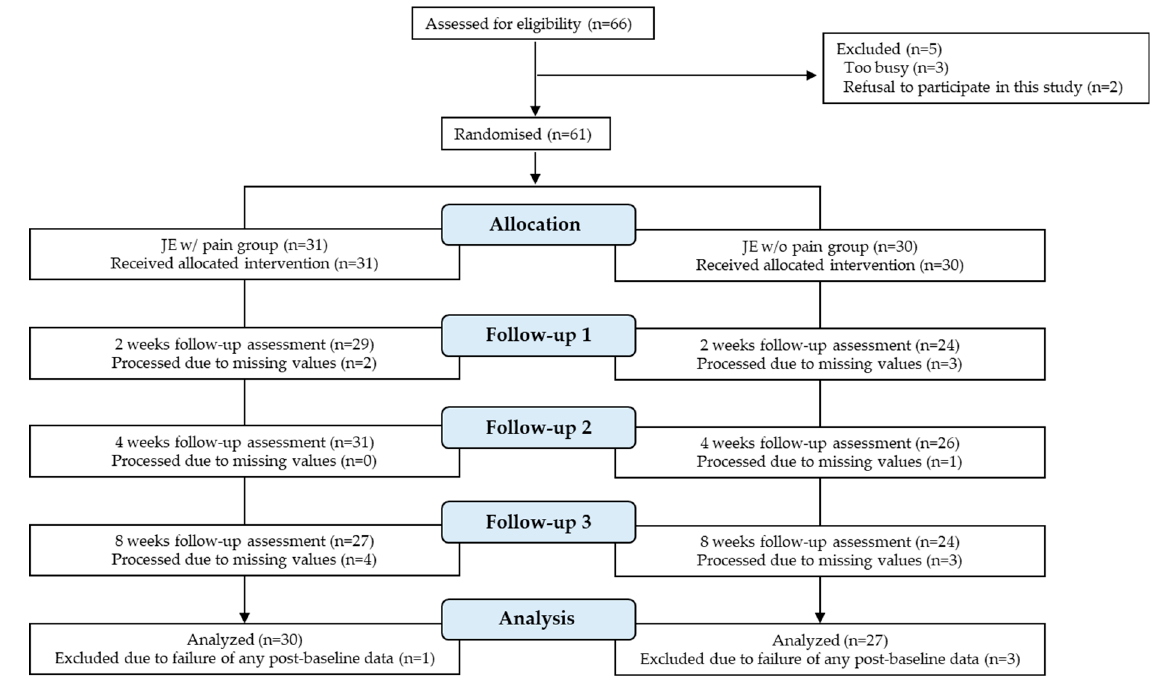
Figure 3. CONSORT flow diagram for our randomized controlled trial. Table 1. Comparison of baseline demographic and outcome variables between the two groups.